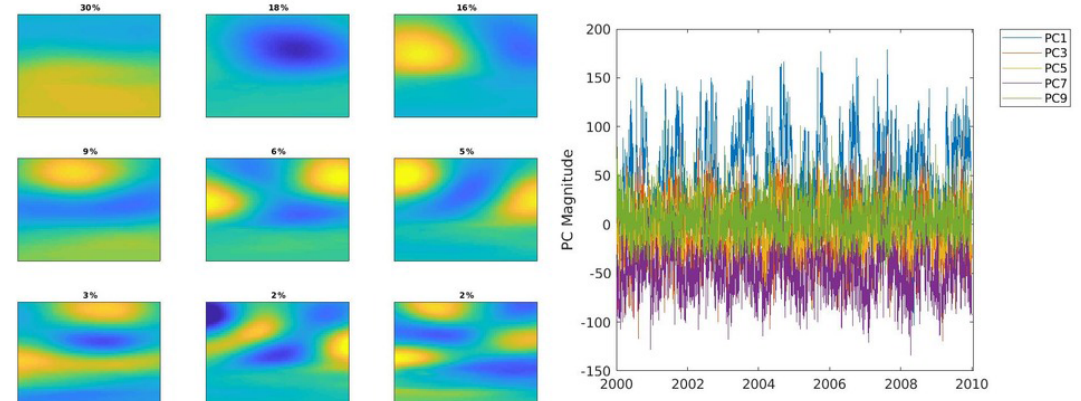
Figure 7. The configurations of the first nine EOFs for surface atmospheric pressure with their relative occurrence are ordered by importance in the decomposition of the variability in the field (represented here unitless, covering the total area of 40–90 ◦ S, 10 ◦ W–60 ◦ E). The time series of the associated PCs for 1 year show the different